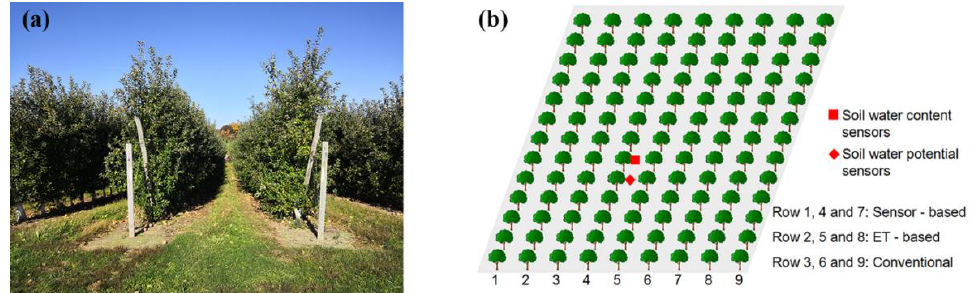
Figure 1. Experimental setup, ( a ) the test apple orchard and ( b ) the setup of three irrigation strategies.